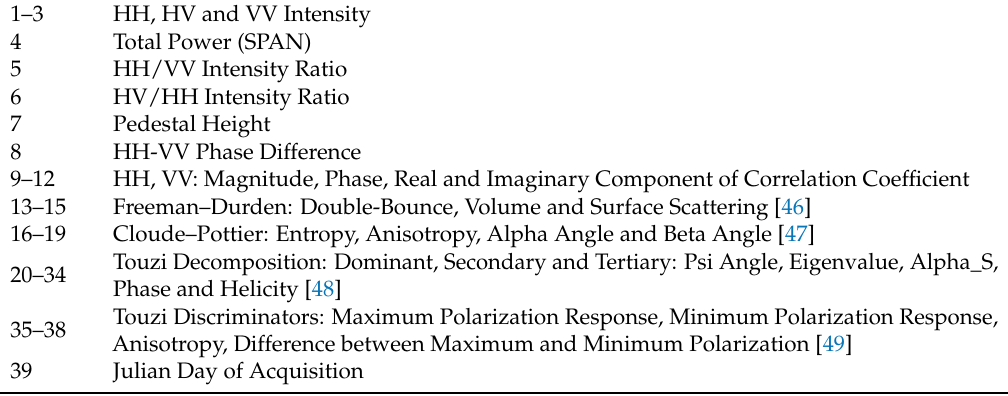
Table 6. List of the 39 SAR variables used to evaluate fully polarimetric RADARSAT-2 data for shoreline mapping. This table is adapted from